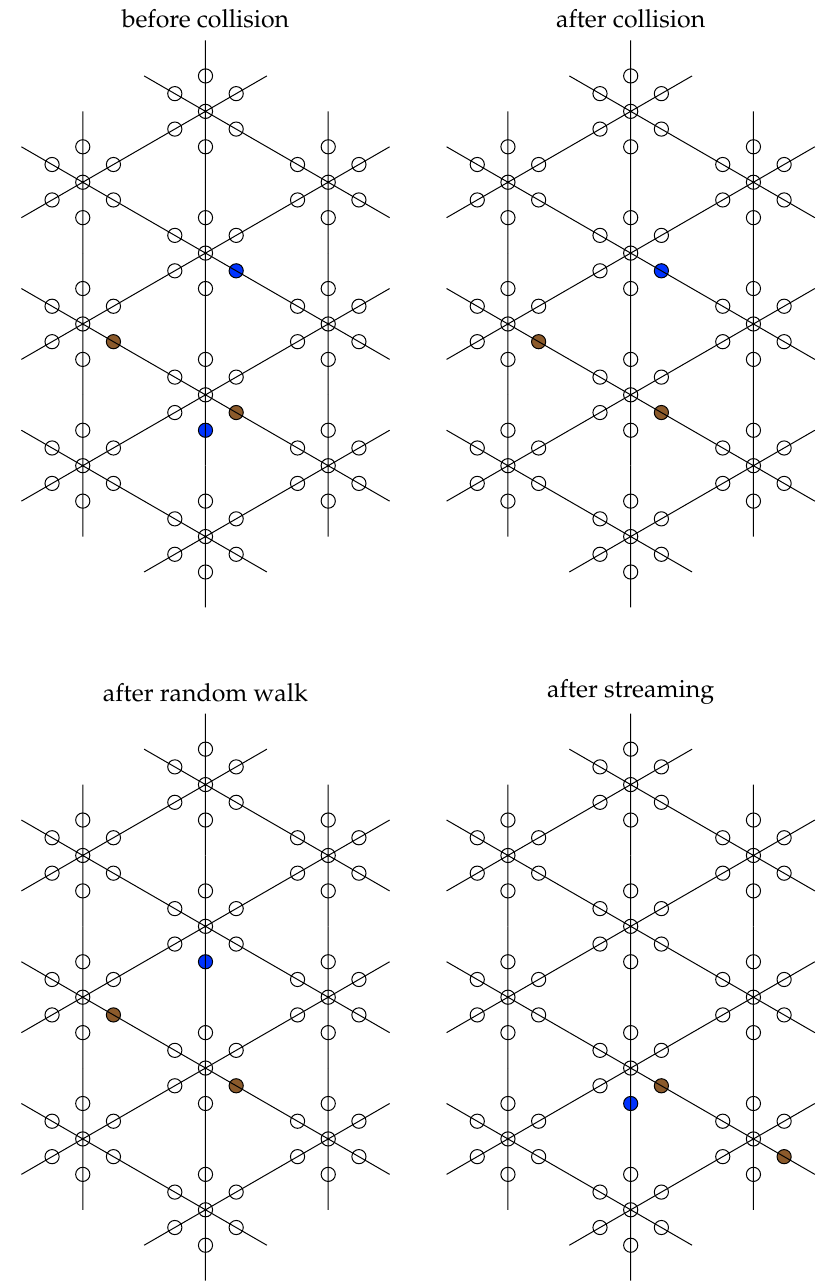
Figure 2. Schematic depiction of the evolution for the gluing model; wood particles (brown), adhesive droplets